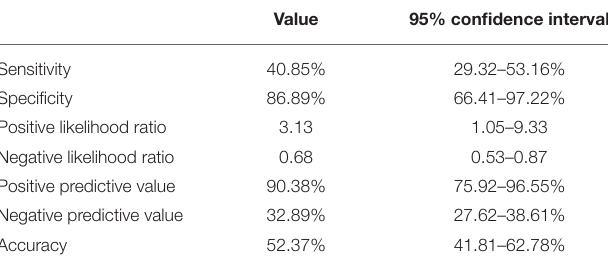
TABLE 4 | Diagnostic sensitivity and specificity of bizarre responses for a schizophrenia spectrum